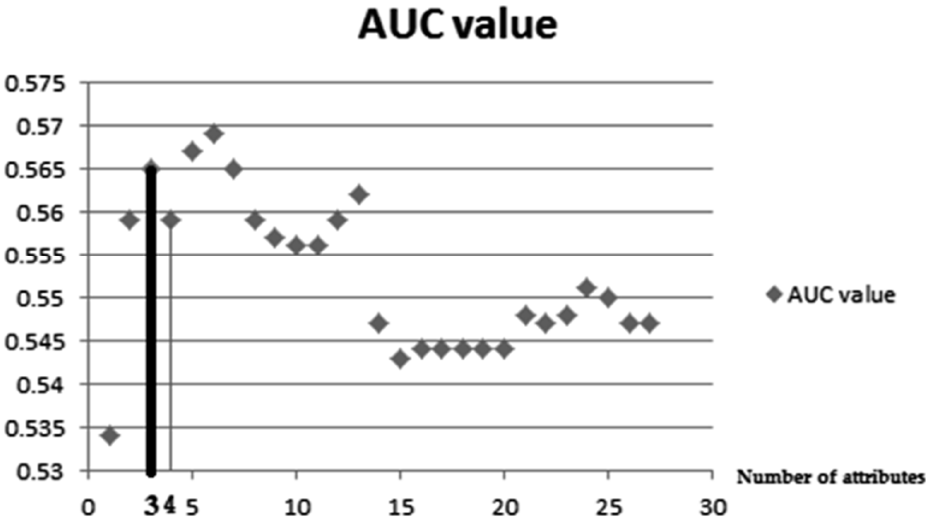
Figure 2. Diagram for determining maximum AUC value of classification for minimum number of attributes.